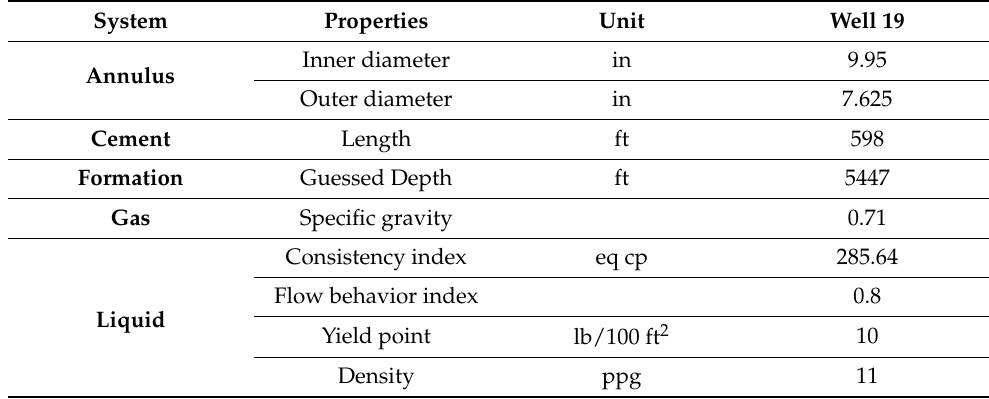
Figure 7. SCP bleed down and build up test for well # 19 (adapted with permission from Kazemi et. al, SPE, 2014). Table 4. System properties as input to the mathematical model (Adapted with permission from Kazemi et. al, SPE, 2014